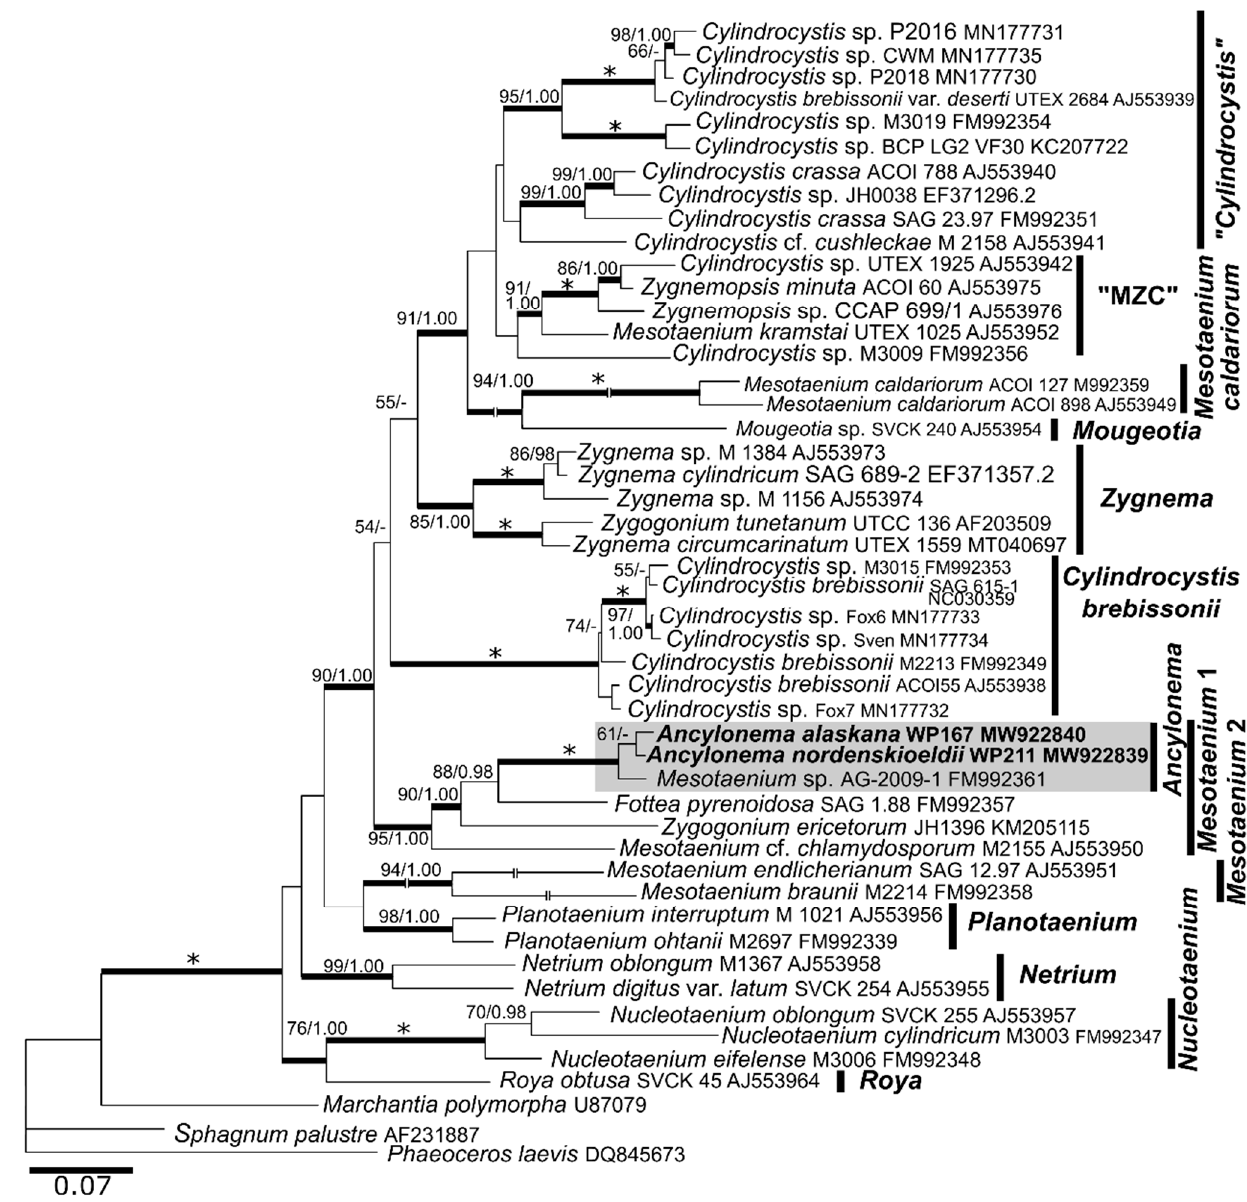
Figure 3. The rbc L gene-based maximum-likelihood phylogenetic tree of selected Zygnematales. The names of clades correspond to [21]. Posterior probabilities ( ≥ 0.95) and bootstrap values from maximum likelihood analyses ( ≥ 50%) are shown. Full statistical support (1.00/100) is marked with an asterisk. Thick branches represent nodes receiving the highest posterior probability support (1.00). Newly obtained sequence in bold. Accession numbers, strain or field sample codes are indicated after each species name.